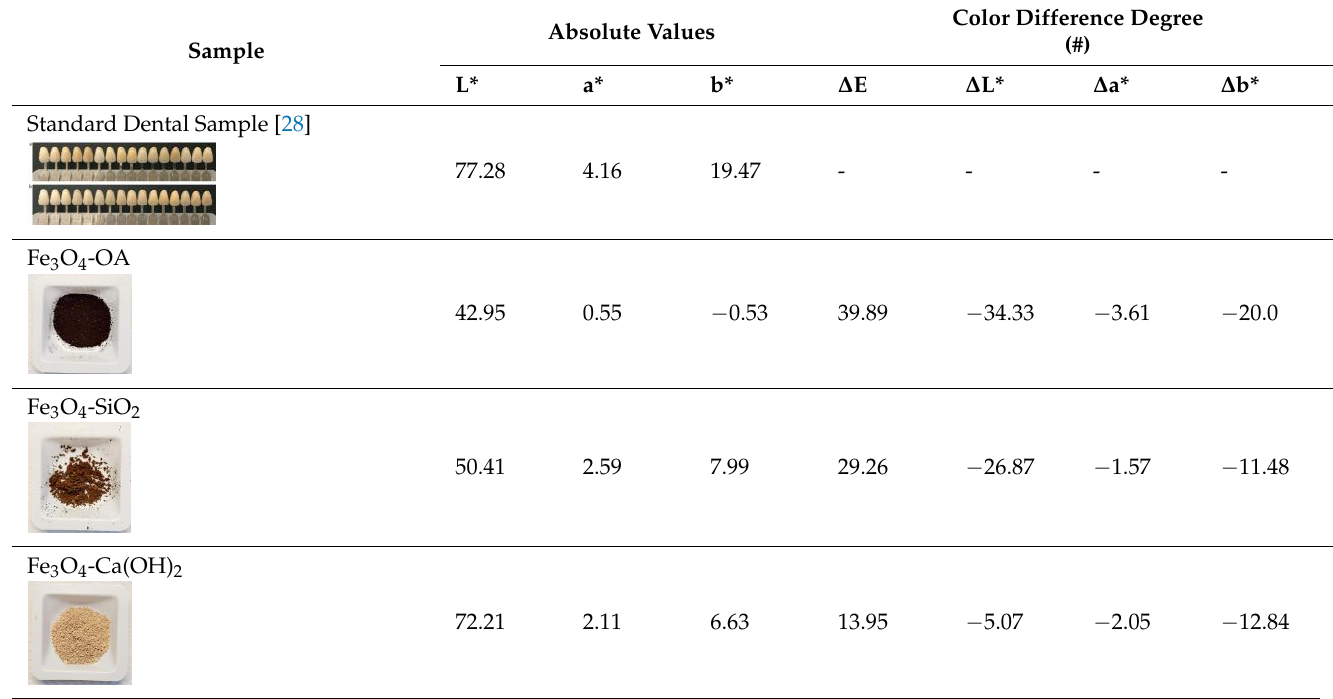
Table 1. Values of brightness L*, color coordinates a* and b*, as well as the degree of color difference